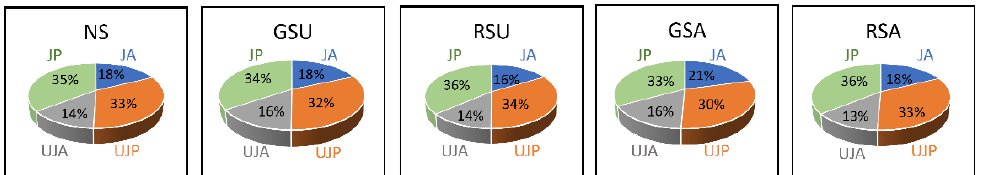
Figure 8. A comparison between the information purchasing rates for all different VoI coefficients.